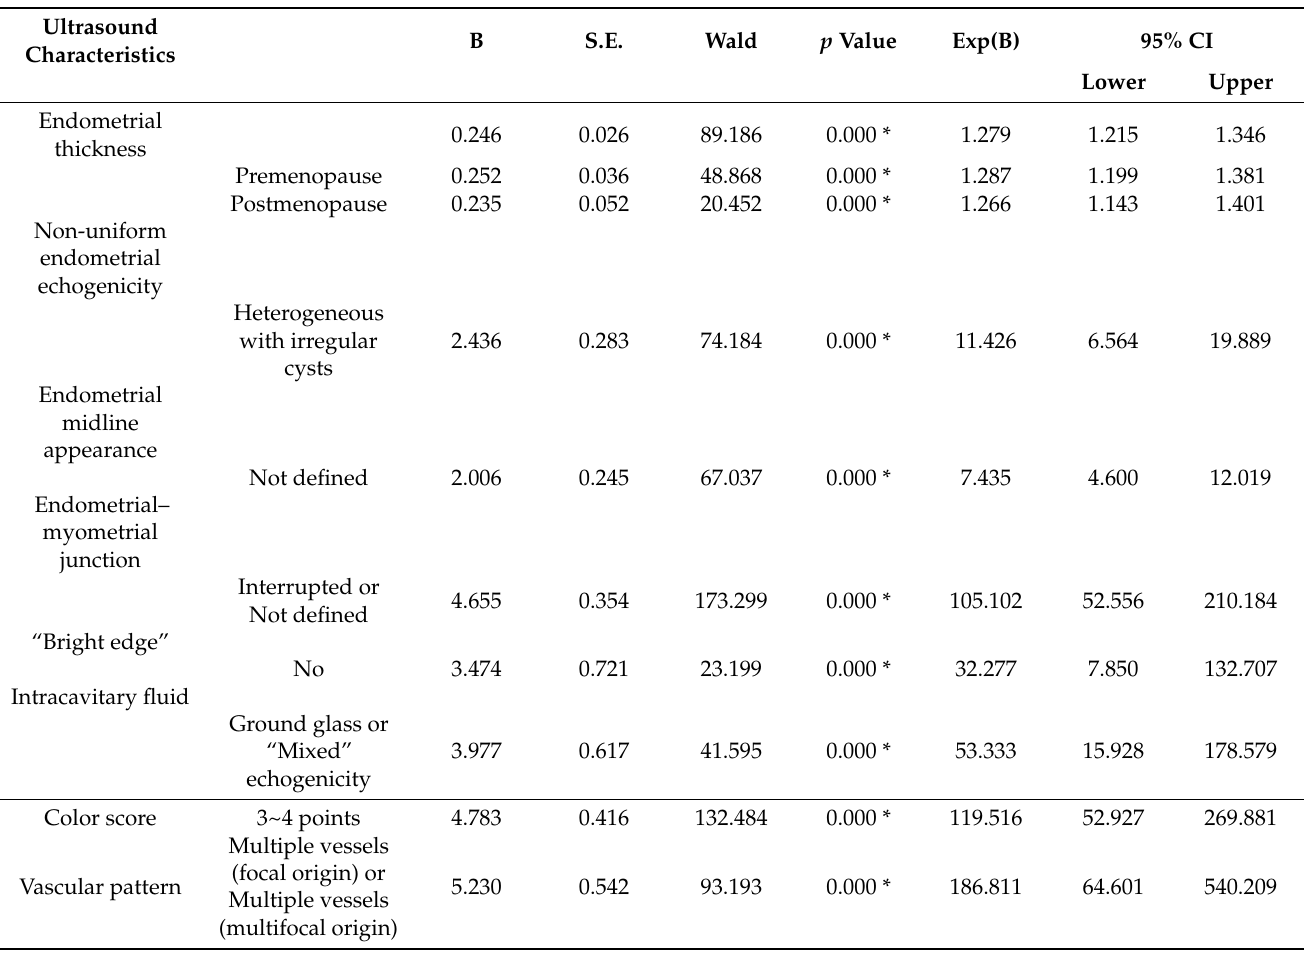
Table 2. Multivariate logistic regression analysis of malignant ultrasonographic signs of uterine cavity and endometrial